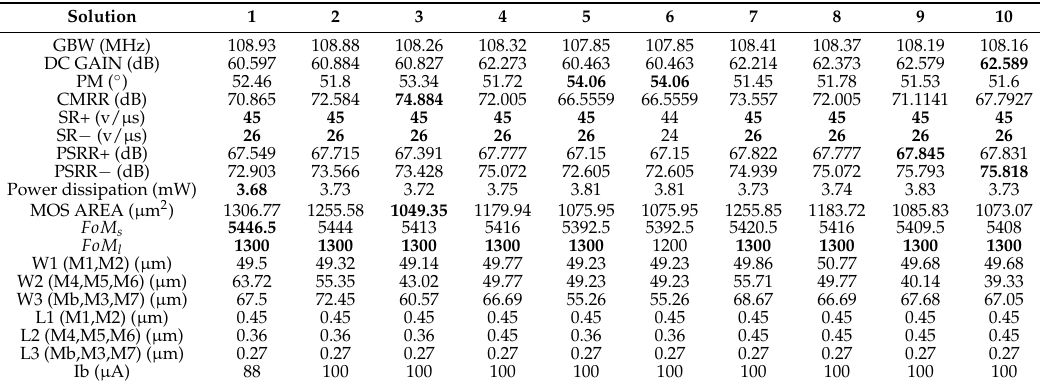
Table 2. Electrical characteristics and feasible W/L sizes of the Miller OTA guaranteeing DCOP conditions of the MOS transistors applying PSO for the best 10 runs. The best values are highlighted in bold face.